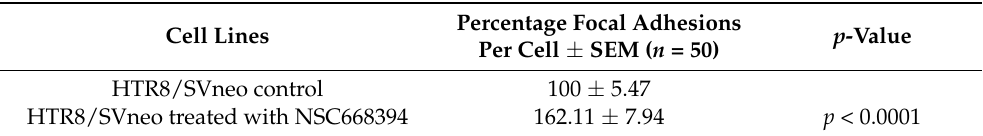
Table 5. Inhibiting ezrin phosphorylation with NSC668394 in HTR8/SVneo trophoblast cells leads to increases in the number of focal adhesions per